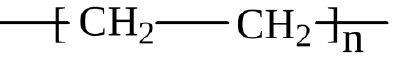
Figure 1. Structural formula of HDPE.